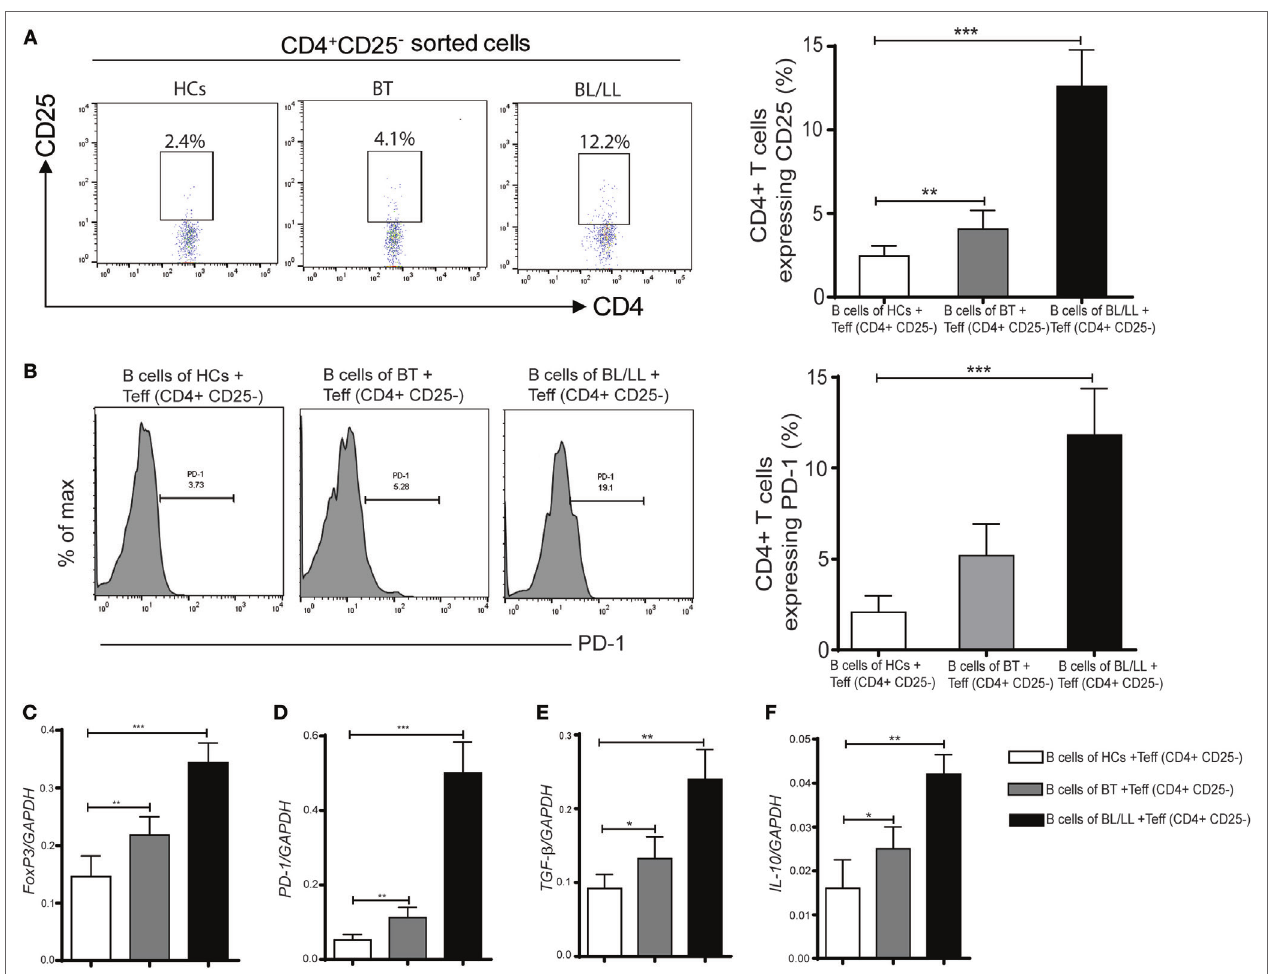
FigUre 3 | Effect of regulatory B cells (Bregs) on Teff (CD4 + CD25 − ) cells. (a) The percentages of Tregs (CD4 + CD25 + ) in various groups [HCs, borderline tuberculoid (BT) and BL/LL, n = 10] showing in flow diagram. Bregs (CD19 + IL-10 + ) derived from (HCs, BT, and BL/LL) were cocultured with Teff (CD4 + CD25 − ) derived from HCs and Tregs were studied by flow cytometry. Graph plot is showing percentage of Tregs in the coculture (Bregs of HCs, BT and BL/LL with Teff of HCs, n = 10). (B) The percentages of inhibitory molecules (PD-1) on Teff (CD4 + CD25 − ) in various groups (HCs, BT, and BL/LL) showing in flow diagram. Bregs (CD19 + IL-10 + ) derived from (HCs, BT, and BL/LL) were cocultured with Teff (CD4 + CD25 − ) derived from HCs and expression of PD-1 on were studied by flow cytometry. Graph plot is showing percentage of PD-1on Tregs in the coculture (Bregs of HCs, BT, and BL/LL with Teff of HCs). (c–F) mRNA expression of FoxP3, PD-1, TGF- β , and IL-10 in the Teff (CD4 + CD25 − ) of HCs, BT, and BL/LL cocultured with Teff. Mean ± SD values are shown in each set while p value < 0.05 was considered significant. 50,000 cells were acquired and analyzed by flow cytometry. Data analysis was performed with flowjo software. Statistical analysis was done using Student’s t -test for unpaired samples (* p < 0.05; ** p < 0.005; *** p <